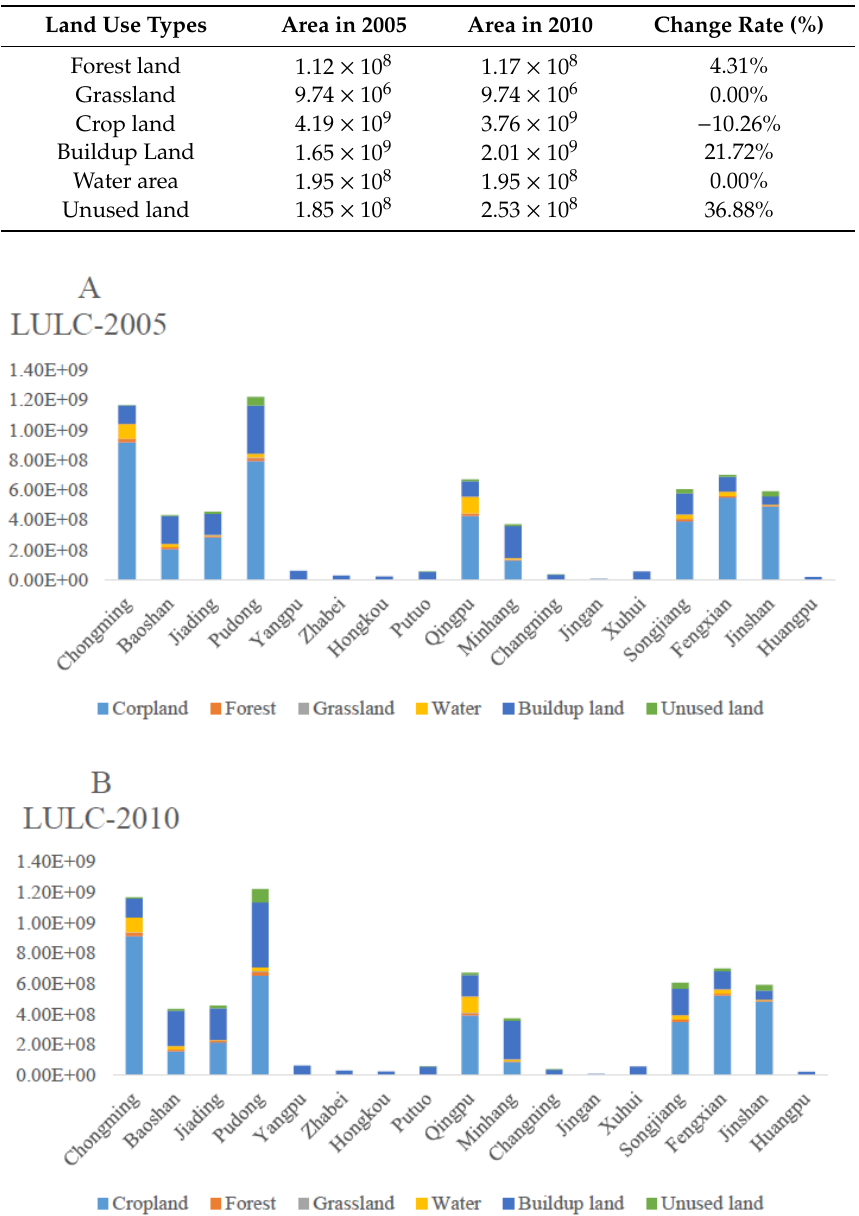
Figure 4. Land use and Land cover (LULC) at district-level. ( A ): LULC in 2005, ( B ): LULC in 2010.